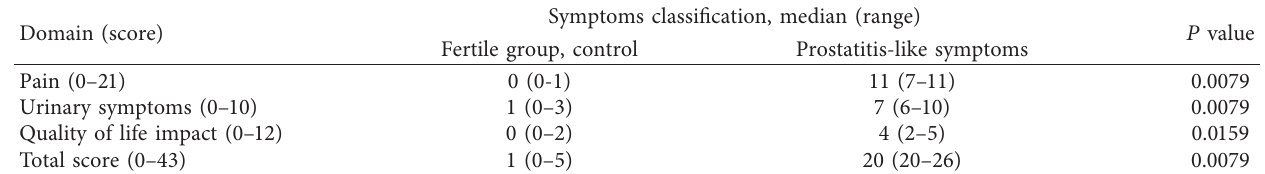
Table 1: NIH–CPSI classification of volunteers.